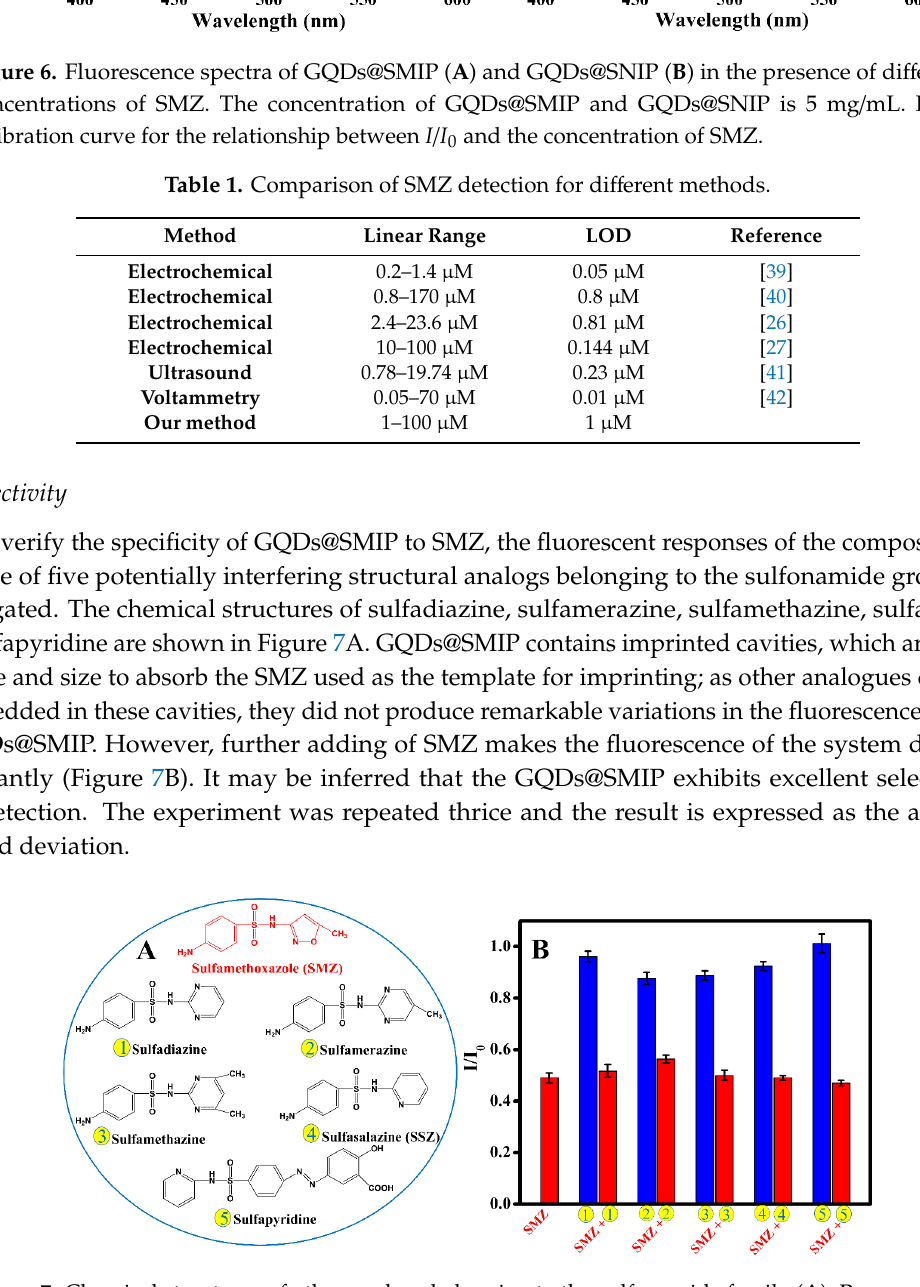
Figure 7. Chemical structures of other analogs belonging to the sulfonamide family ( A ). Responses of GQDs@SMIP to different analogs at the same concentration of 140 µM ( B ).